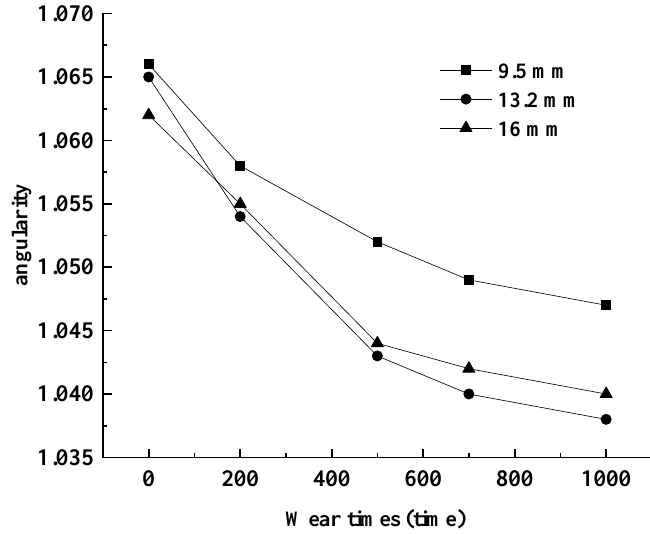
Figure 2. Changes in the angularity of aggregates.